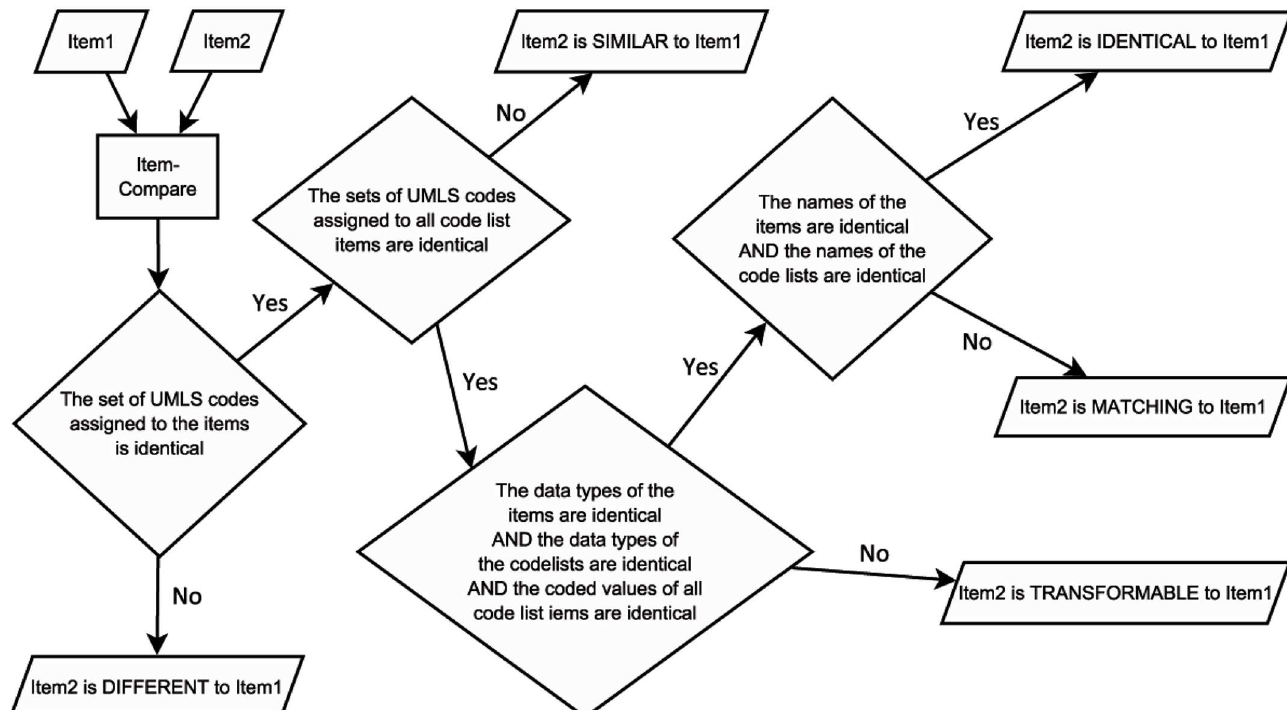
Fig 3. Flowchart of the ODMSummary compare